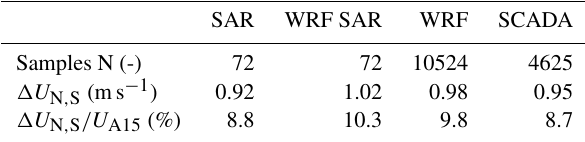
Table 3. Sample sizes, difference between wind speed at the most northern and southern turbines (cid:49)U N , S (three turbine location aver- aged, see Eq. 1), and the same difference normalized with the wind speed at turbine U A15 at turbine